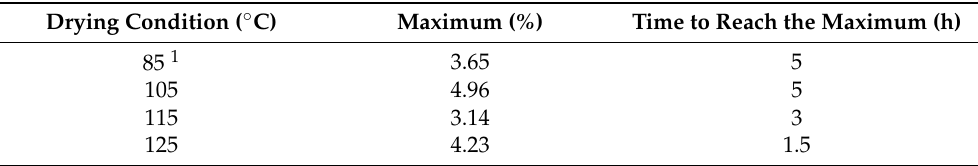
Table 2. Maximum values of mechano-sorptive creep strain of surface wafer